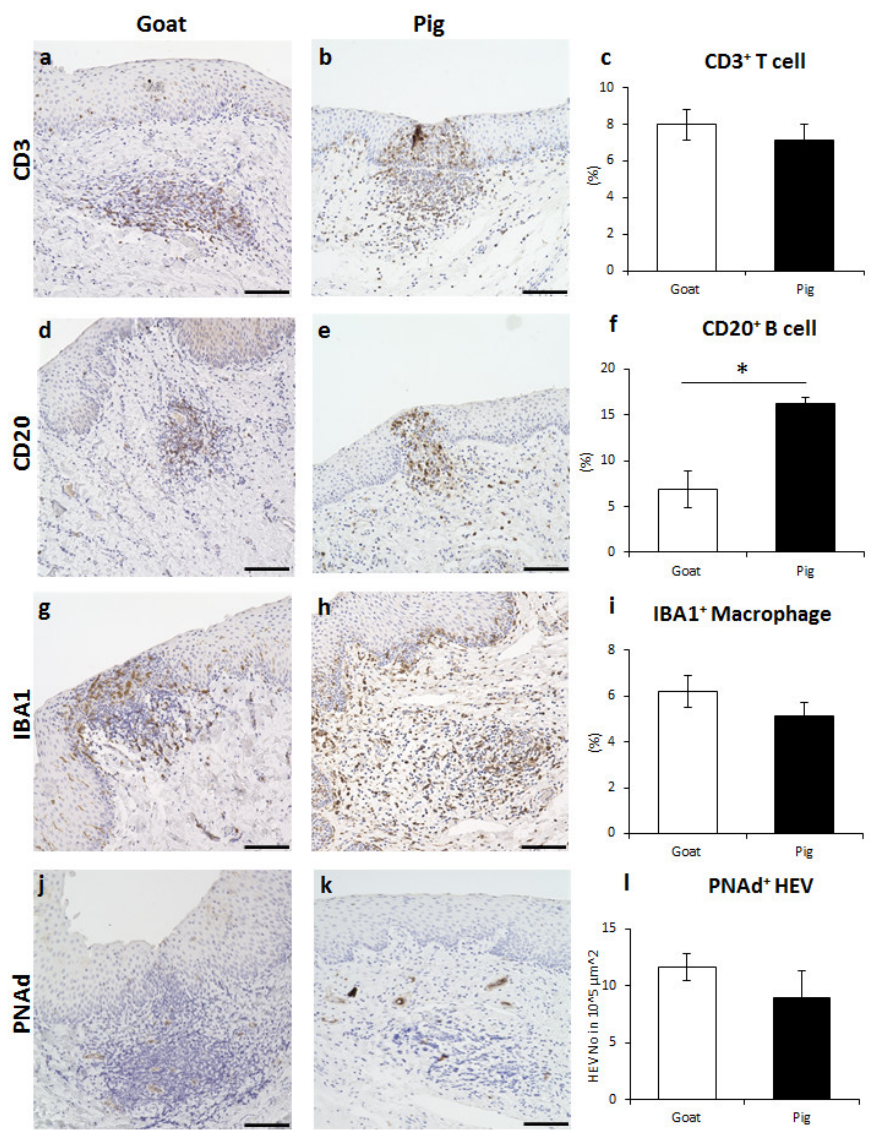
Figure 4. Immune cell characteristics composing DLT in goat and pig VV. ( a , b ) CD3 for T cells of goat and pig. ( c ) Positive percentage of CD3 + T cells localizing in the LN. Values = mean ± SE. n ≥ 4. ( d , e ) CD20 for B cells of goat and pig. ( f ) Positive percentage of CD20 + B cells localizing in the LN. Values = mean ± SE. n ≥ 4. Significant difference between the goats and pigs was indicated by *, p < 0.05; Mann–Whitney U test. ( g , h ) IBA1 for macrophages of goat and pig. ( i ) Positive percentage of IBA1 + macrophages occupying the LN. Values = mean ± SE. n ≥ 4. ( j , k ) PNAd for HEVs of goat and pig. ( l ) Number of PNAd + HEVs in 10 5 μm 2 in LN. Values = mean ± SE. n ≥ 4 . Scale bars = 100 μm.